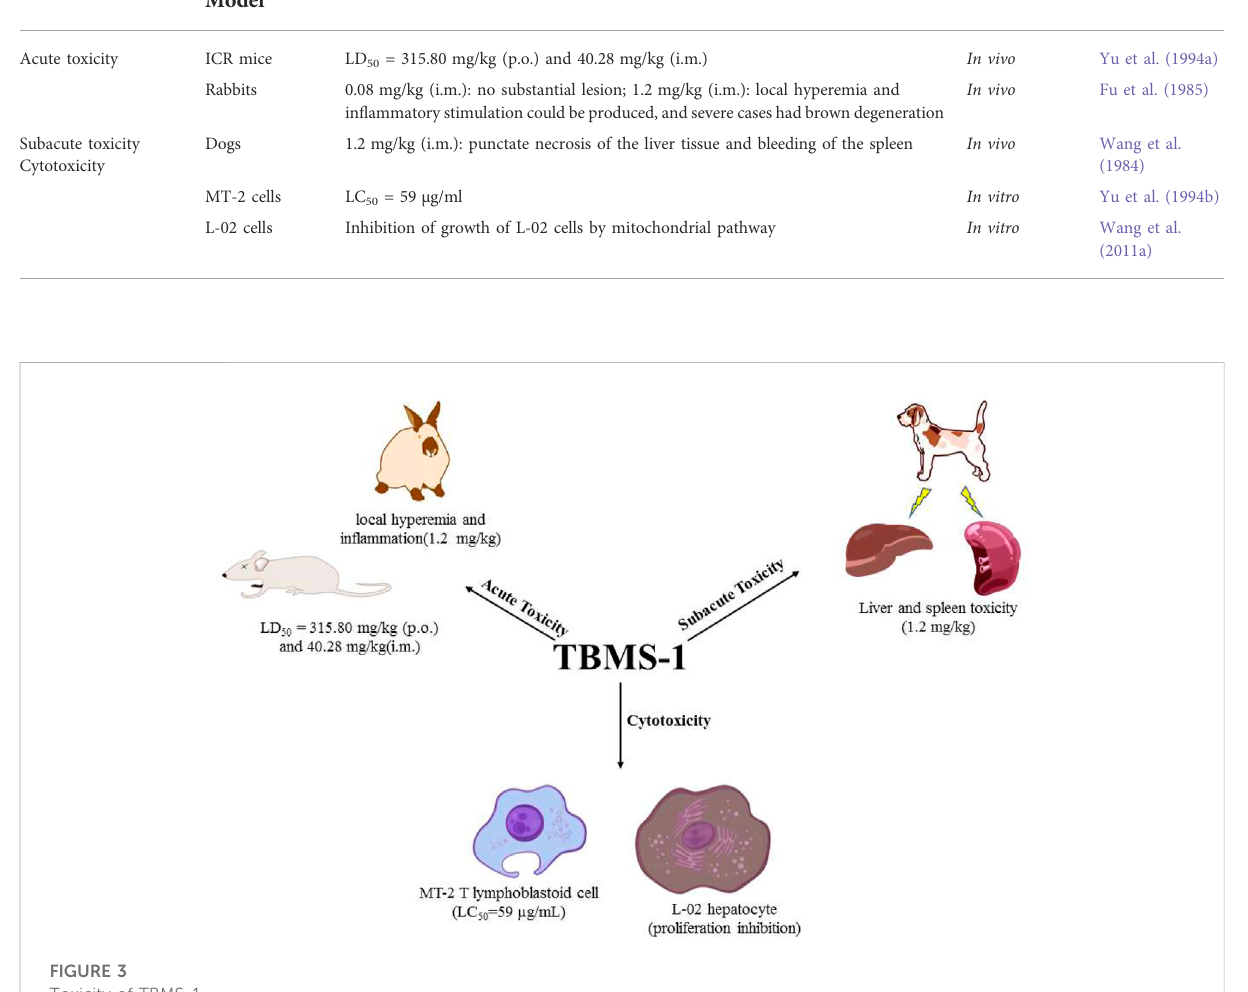
FIGURE 3 Toxicity of